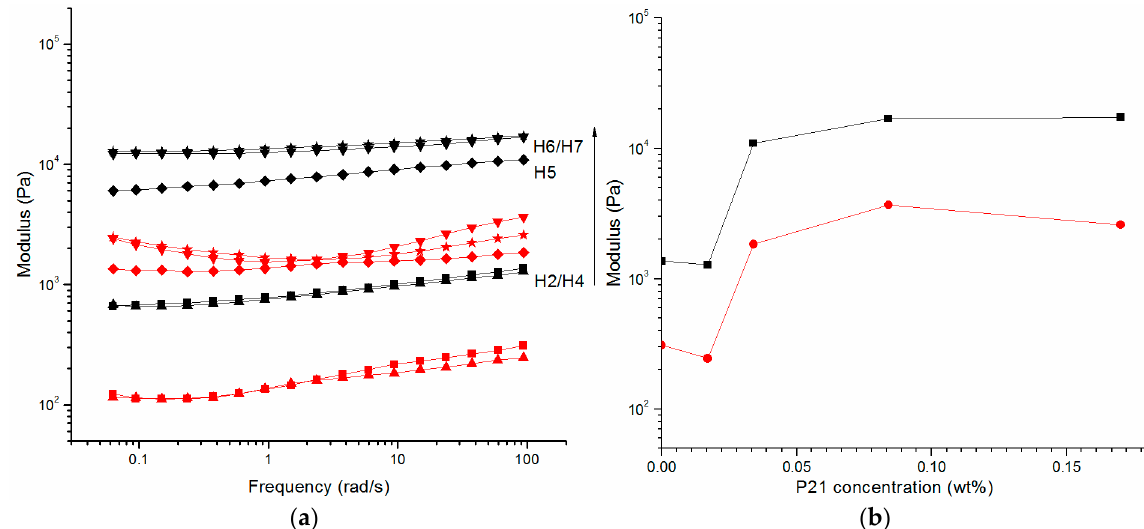
Figure 5. Rheology of hydrogels of P5 1% ( w / v ) with different concentration of P21. ( a ) Dynamic frequency sweep at 0.2% of strain of H2 ( (cid:4) ), H4 ( (cid:78) ), H5 ( (cid:7) ), H6 ( (cid:72) ), and H7 ( (cid:70) ) hydrogels. Black symbols report storage moduli (G’), while red symbols report loss moduli (G’’); ( b ) storage modulus (G’) in black and loss modulus (G’’) in red at 0.2% strain and 9.4 rad s − 1 as a function of concentration of P21 peptide.